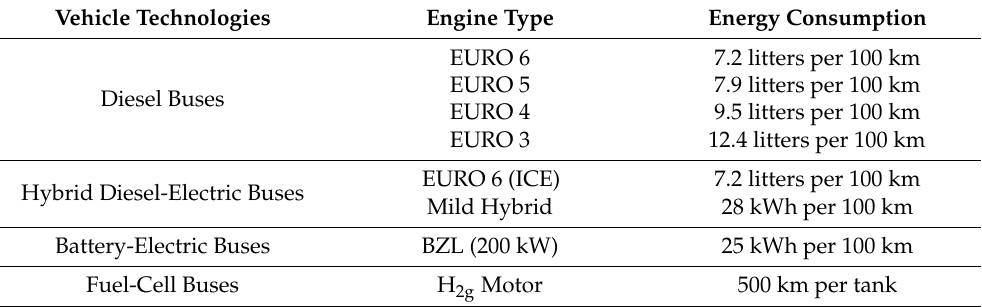
Table 4. Technical Specifications of Studied